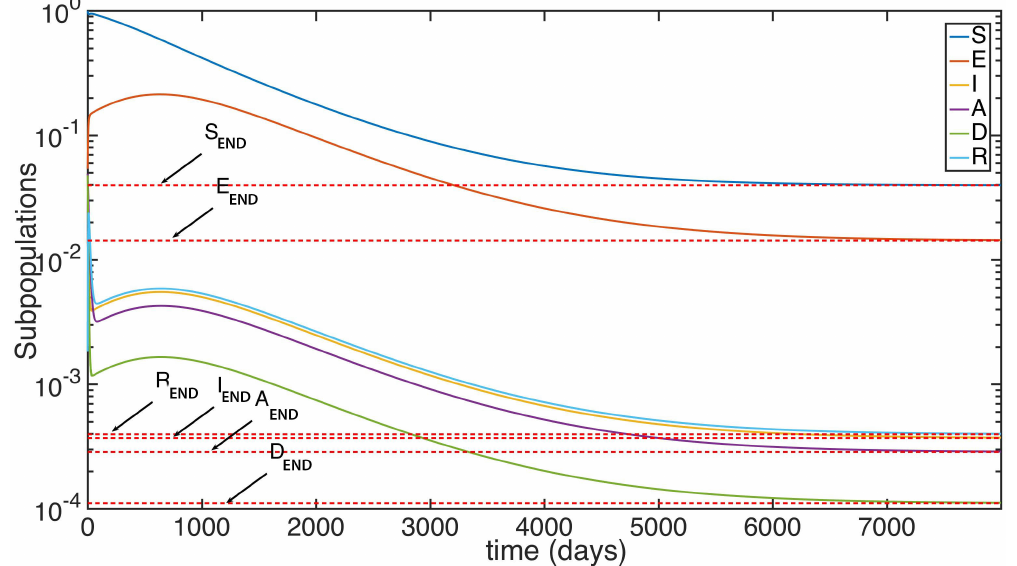
Figure 3. Time evolution of the different subpopulations given a R 0 =